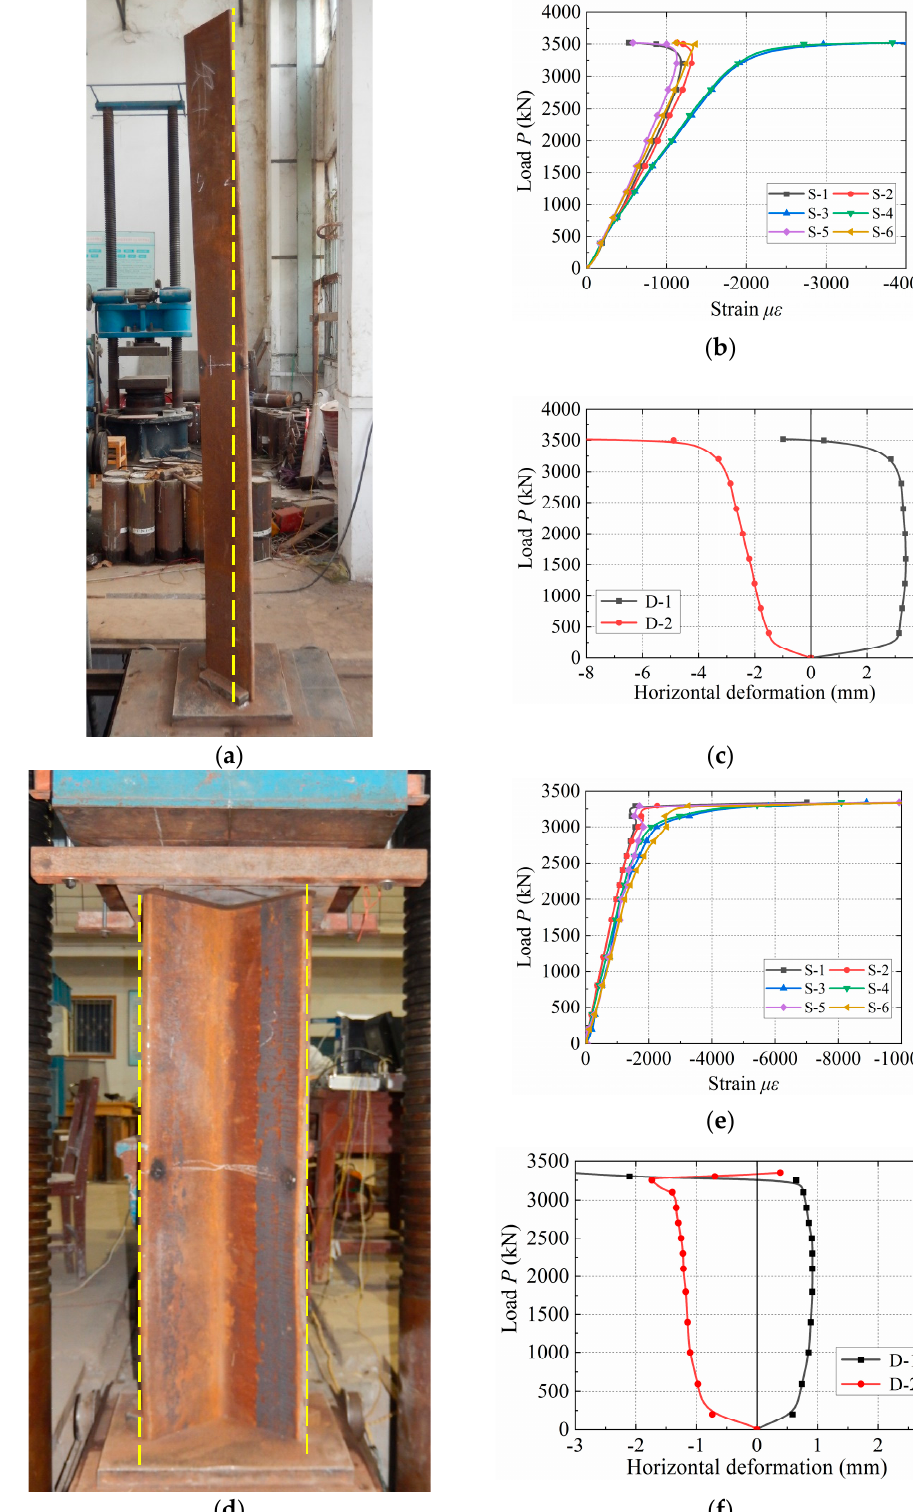
Figure 7. Test results: ( a ) ∟ 220 × 26-60-1, flexural buckling; ( b ) ∟ 220 × 26-60-1, load–strain curve; ( c ) ∟ 220 × 26-60-1, load–horizontal deformation curve; ( d ) ∟ 220 × 22-30-1, flexural–torsional buckling; ( e ) ∟ 220 × 22-30-1, load–strain curve; ( f ) ∟ 220 × 22-30-1, load–horizontal deformation curve.